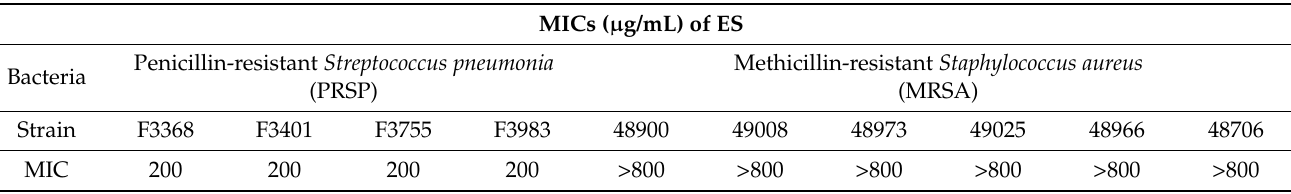
Table 2. Antibacterial effect of ES on drug-resistant clinical